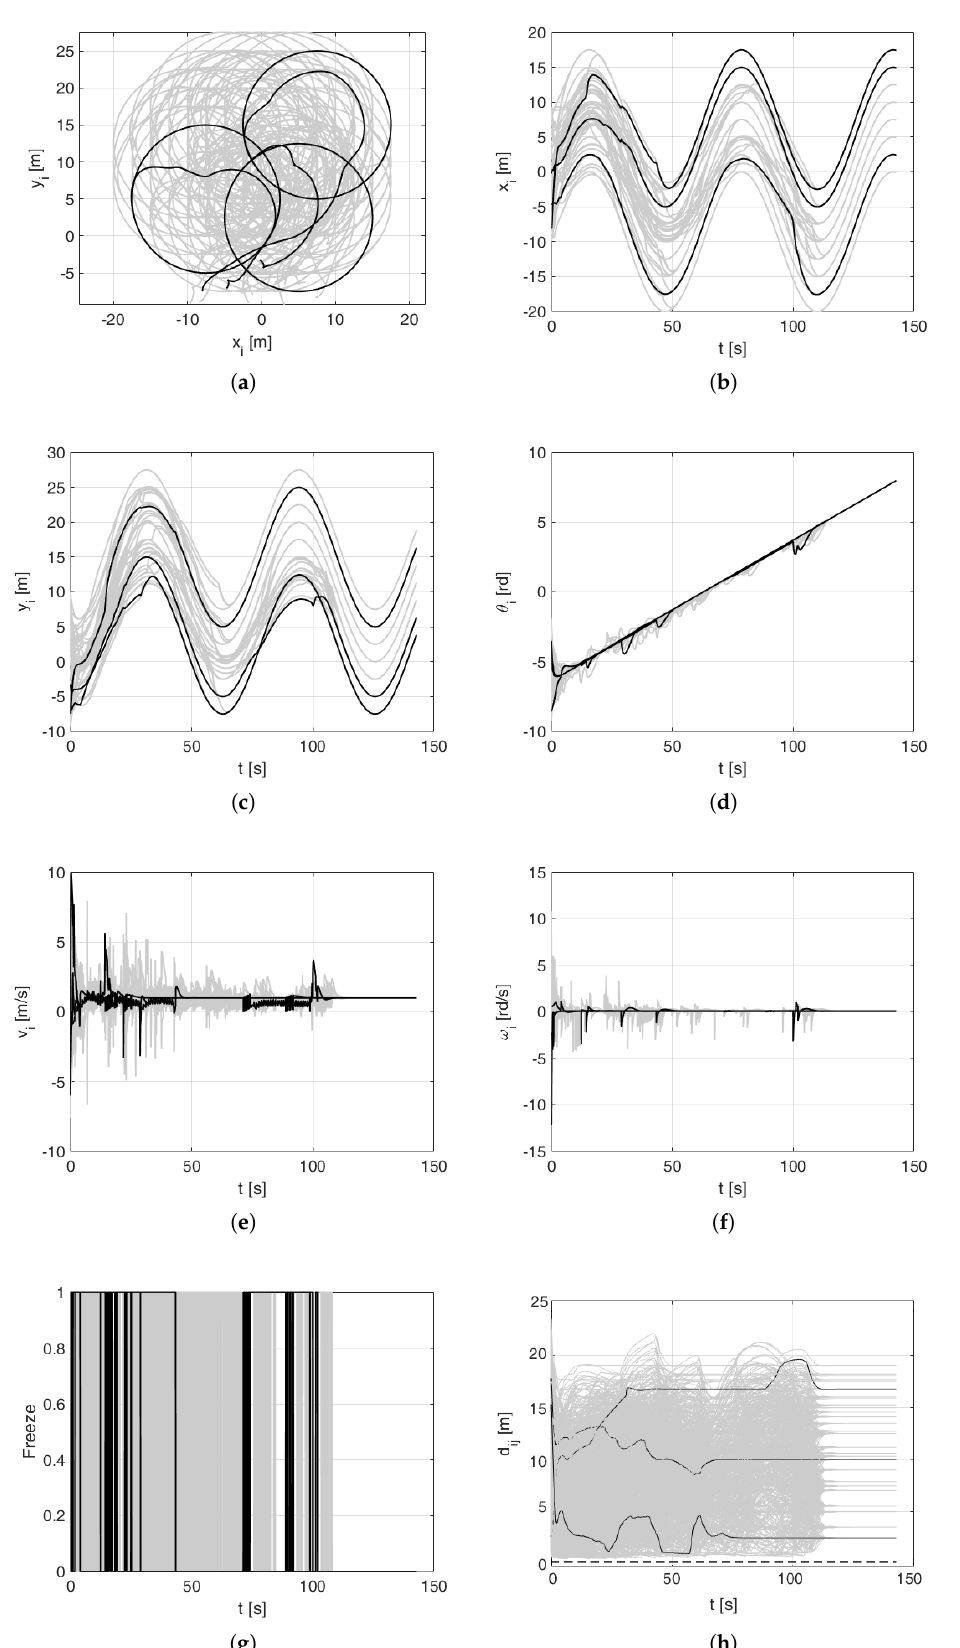
Figure 5. Numerical simulation 1: trajectory tracking for N = 48 robots. ( a ) locations of robots in xy -plane, ( b ) x coordinates as a function of time, ( c ) y coordinates as a function of time, ( d ) robot orientations as a function of time, ( e ) linear velocity controls, ( f ) angular velocity controls, ( g ) ‘freeze’ signals, ( h ) distances between